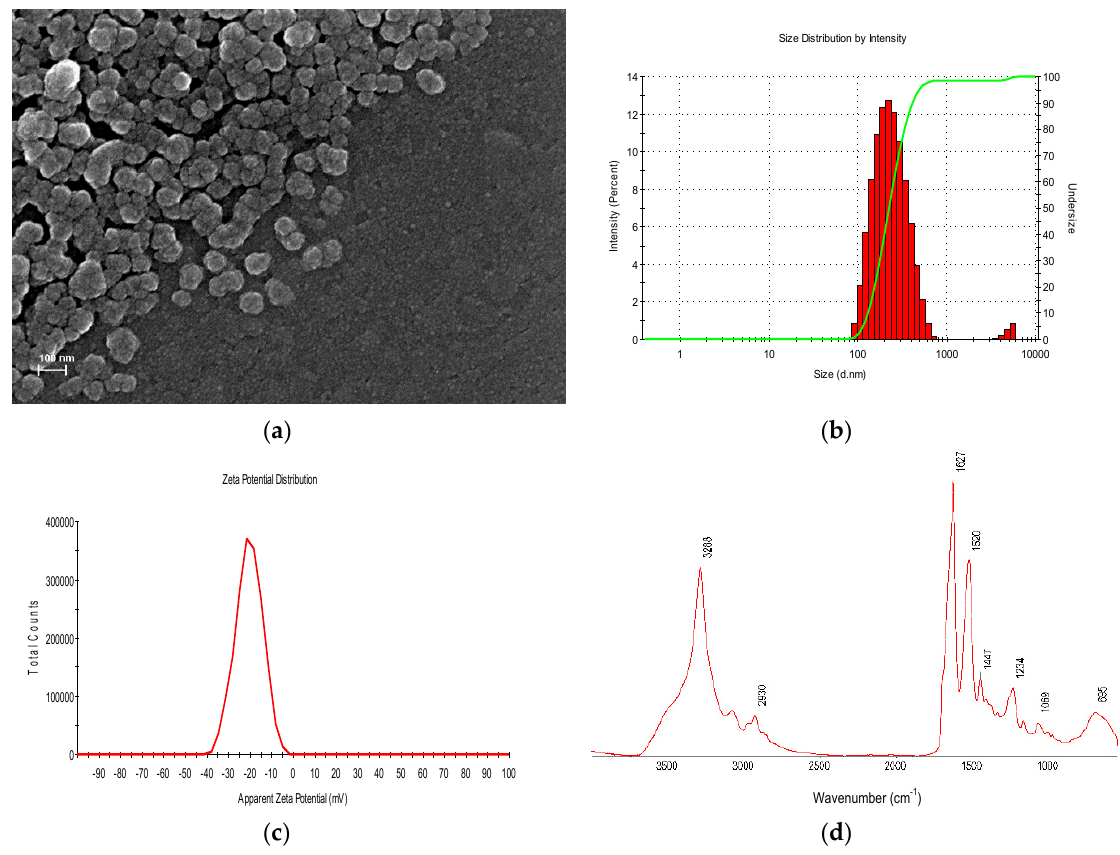
Figure 1. Characterization of RME–SFNs: ( a ) FESEM image of the freeze dried nanoparticles. ( b ) Size distribution (diameter in nm) by Intensity (%) measured by DLS. ( c ) Z-potential distribution and ( d ) ATR–FTIR spectrum. Table 3. Characterization of the silk fibroin nanoparticles by Dynamic Light Scattering. Sample Z average (d.nm)